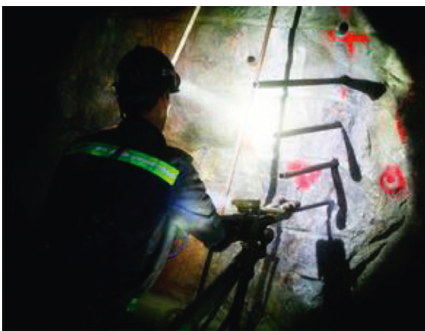
Figure 7: Drilling construction using the air pressure gun.